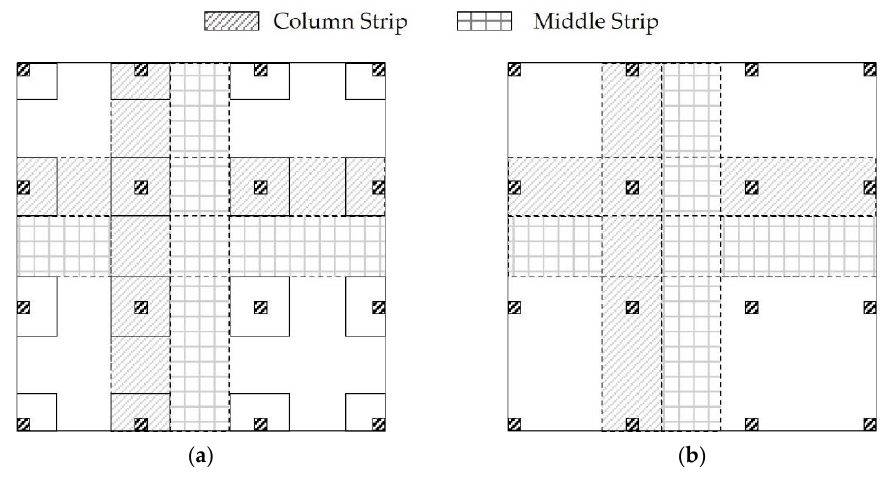
Figure 3. Column and middle strips for flat slabs: ( a ) FSWD; ( b ) FP.